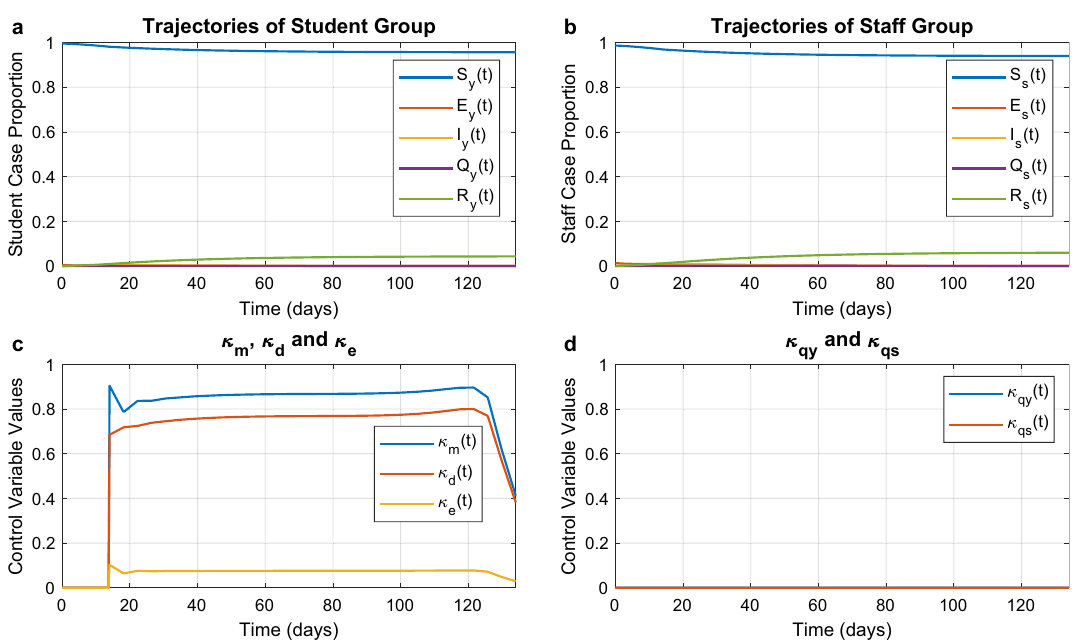
Figure 6. Optimal trajectories for the minimum quarantine scenario. Optimal trajectories when the department would like to minimise the enforcement of mandatory quarantines. ( a ) and ( b ) The epidemic evolution among students and staff, respectively. ( c ) The optimal strategies for mask wearing ( κ m ), social distancing ( κ d ), and environmental disinfection ( κ e ). ( d ) The optimal strategies for mandatory quarantine on infected students ( κ qy ) and infected staff ( κ qs